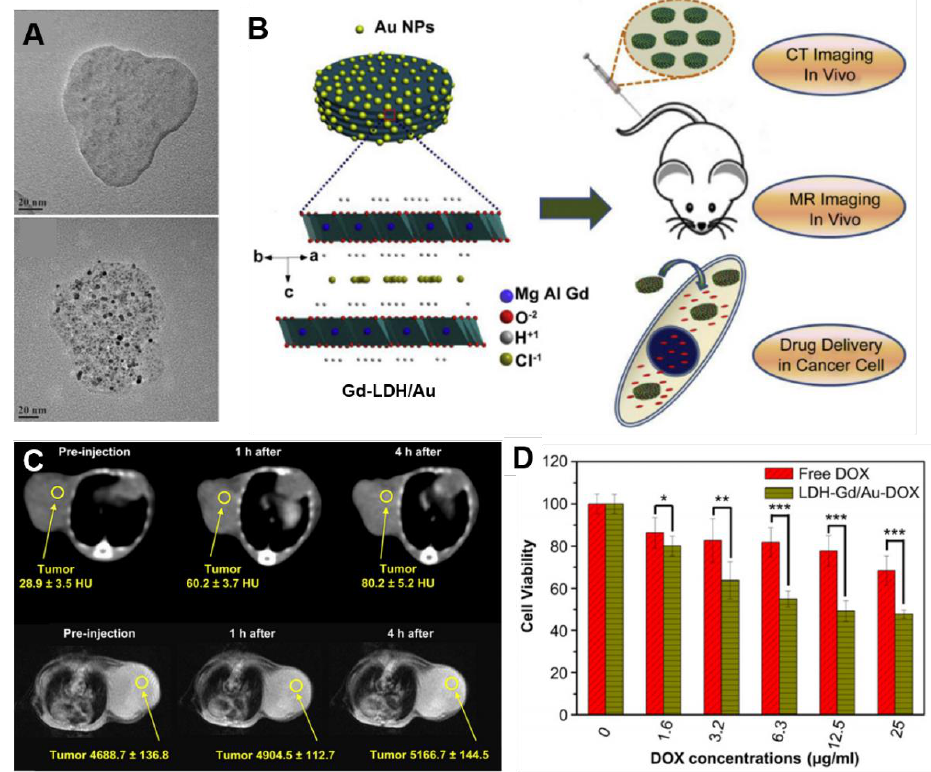
Figure 8. ( A ) TEM images of Gd-LDH and Gd-LDH/Au, ( B ) Schematic illustration of the Gd-LDH/Au as a theranostics platform for dual modal CT-MR imaging and anti-cancer drug delivery, ( C ) CT (top) and T 1 -weighted MR images (bottom) of tumor after intravenous injection of Gd-LDH/Au-heparin in 4 T1 murine breast tumor-bearing mice for 0 h, 1 h and 4 h; ( D ) HeLa cell viabilities when exposed to free DOX and Gd-LDH/Au-DOX at different concentrations (* p < 0.05, ** p < 0.01, *** p < 0.001), reproduced from [10], with permission from Elsevier Ltd., 2013.